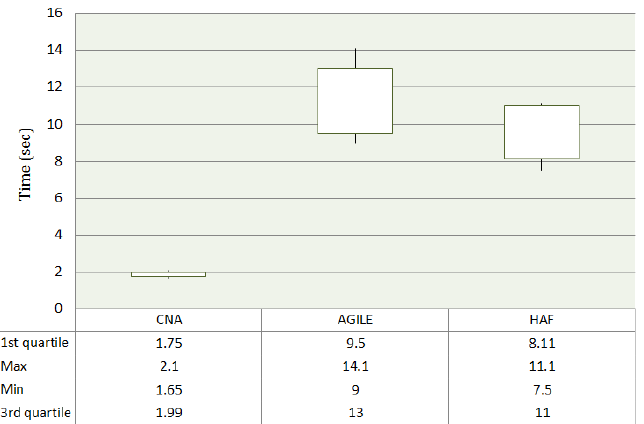
Figure 11. Time each algorithm takes to calculate a set of grasps, based on 10 function calls for 10 different